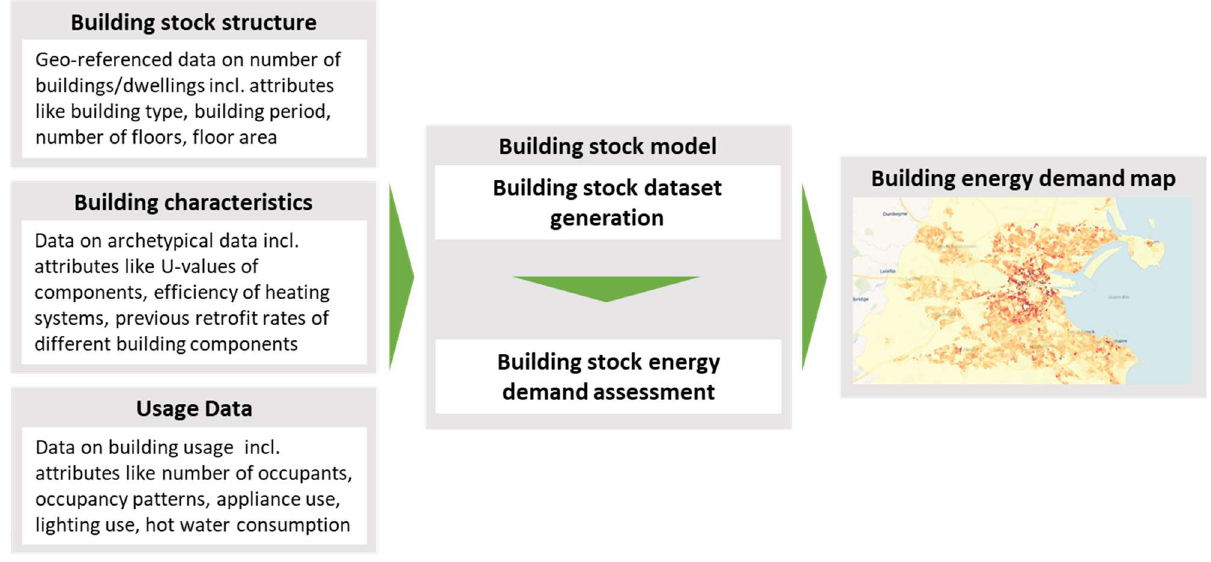
Figure 1. Synthetic spatial building stock modelling for spatial energy demand analysis.